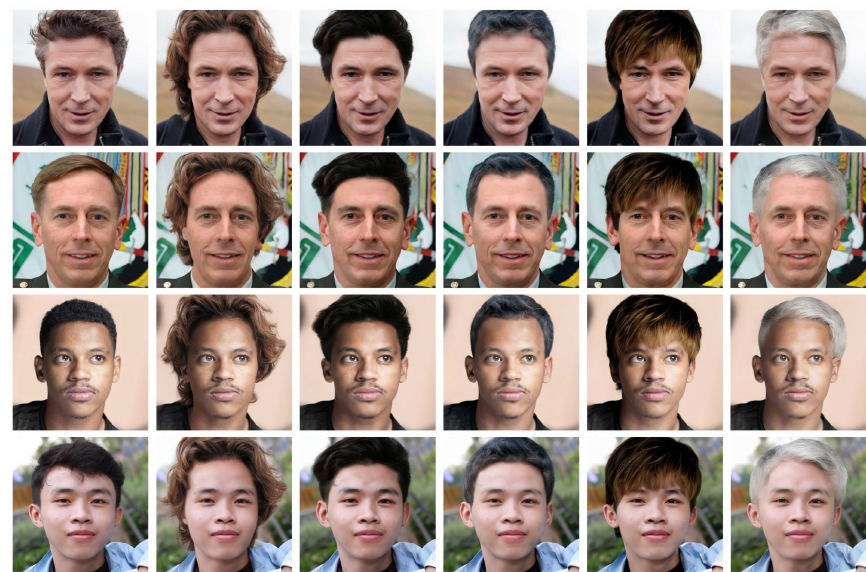
Figure 9. Comparison of different new hairstyles for